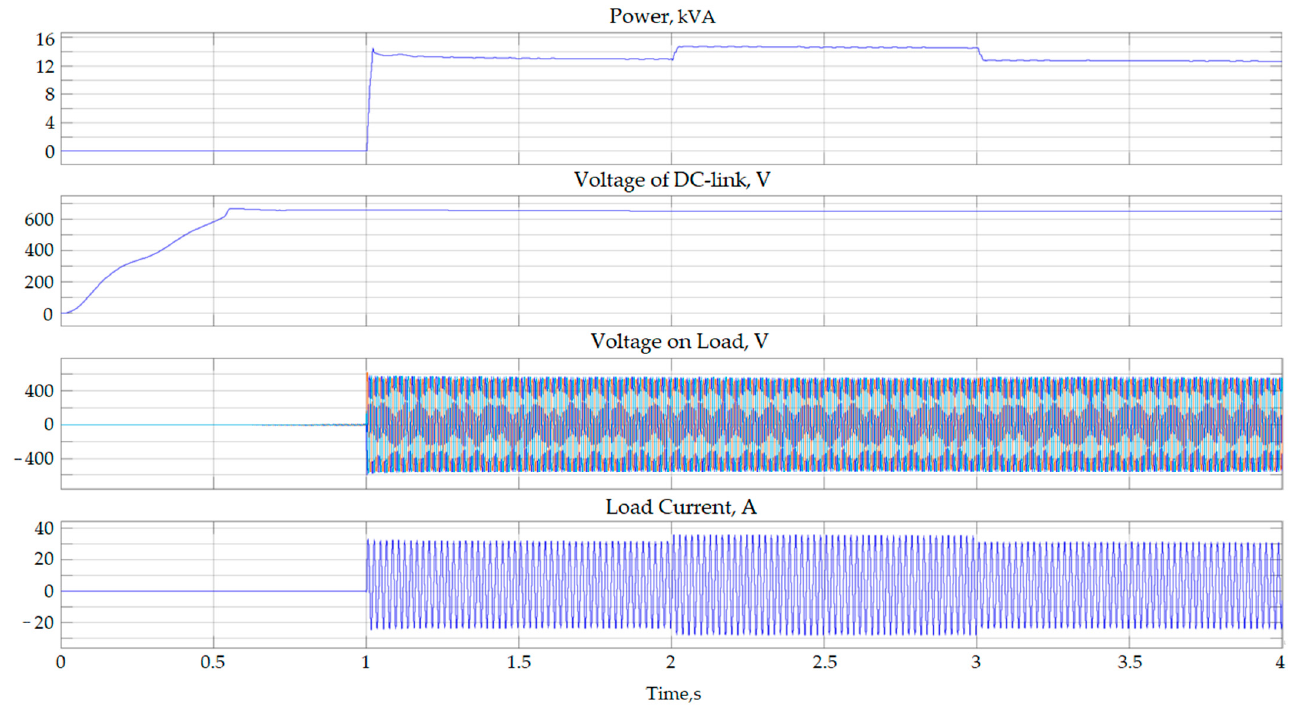
Figure 11. Oscillograms of the apparent power, DC link voltage, load voltage, and load current.